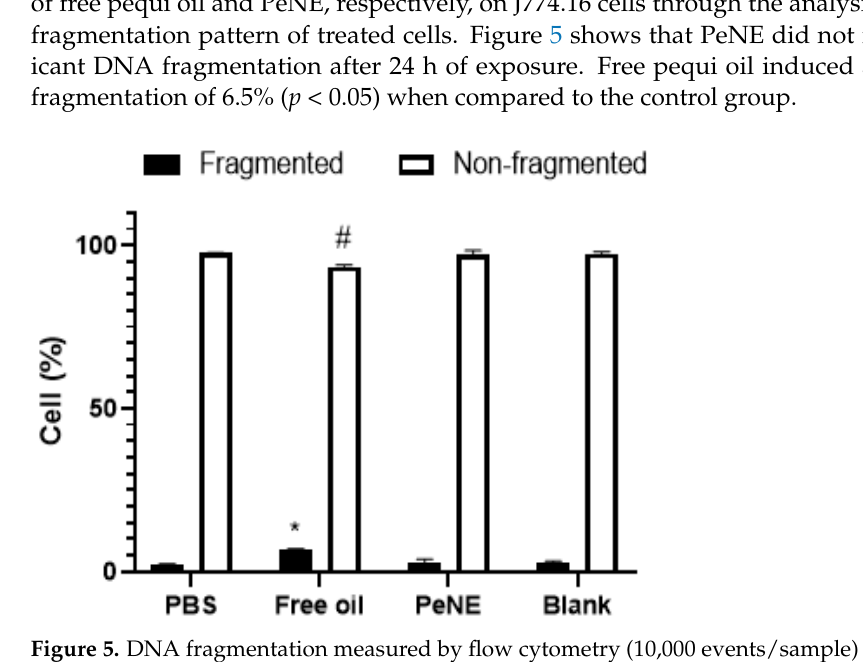
Figure 5. DNA fragmentation measured by flow cytometry (10,000 events/sample) in macrophage cells (J774.16) exposed to NePE (360 µg/mL), blank, and free pequi oil (180 ug/mL) for 24 h. Phosphate buffer and ethanol were used as controls. Two-way ANOVA: significant difference among fragmented groups * ( p < 0.05) and non-fragmented group # ( p < 0.05) (Tukey post hoc test). 3.4. Evaluation of Anti-Inflammatory and Analgesic Effects of PeNE and Free Pequi Oil In Vivo To evaluate the anti-inflammatory and antinociceptive effects of PeNE and free pequi oil, daily oral administrations with different concentrations of PeNE and free pequi oil (100 and 400 mg/kg) were carried out for 15 days, before the induction of a local (paw) acute inflammation with carrageenan. Figure 6 shows the oral treatment effects of PeNE or free pequi oil on behavioral tests. PeNE (100 or 400 mg/kg, both) reduced the hypernociception by 27 and 40%, respectively ( p < 0.05); while free pequi oil reduced it by 40 and 52%, respectively ( p < 0.05) (Figure 6a). The control treatments with dipyrone, a known analgesic drug, and dexamethasone, a potent anti-inflammatory drug, showed a reduction in hypernociception by 79 and 96%, respectively (Figure 6a). Besides showing an antinociceptive effect, the treatment with PeNE or free pequi oil (same doses) did not show an effect against the carrageenan-induced edema (Figure 6b). As expected, dipyrone did not show an anti-inflammatory effect and dexamethasone inhibited the edema by 82% ( p < 0.05). The antinociceptive effect observed by oral treatments with PeNE or free pequi oil is not due to motor coordination impairment since no significant difference was observed among treatments (Figure 7).